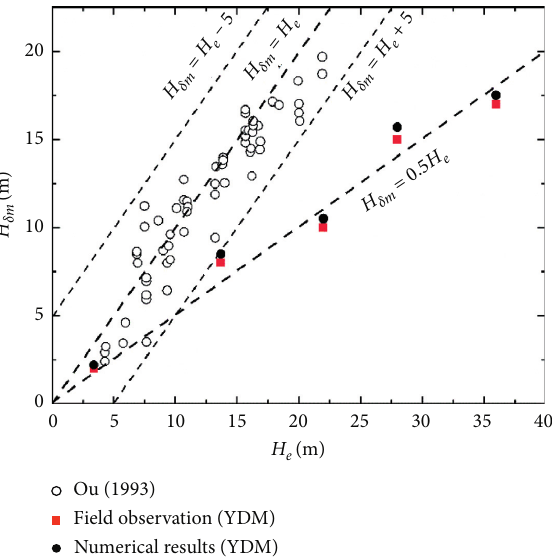
for YDM and other dates. hm